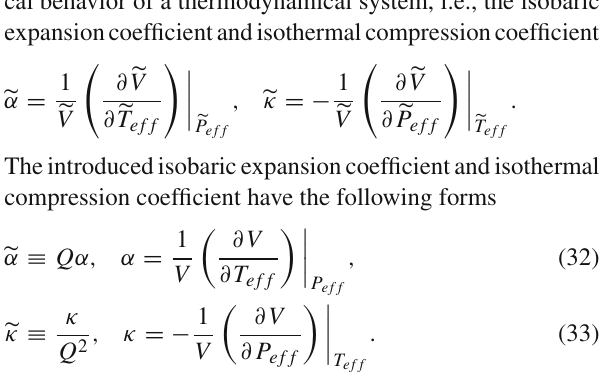
(blue thin line), and 1 30